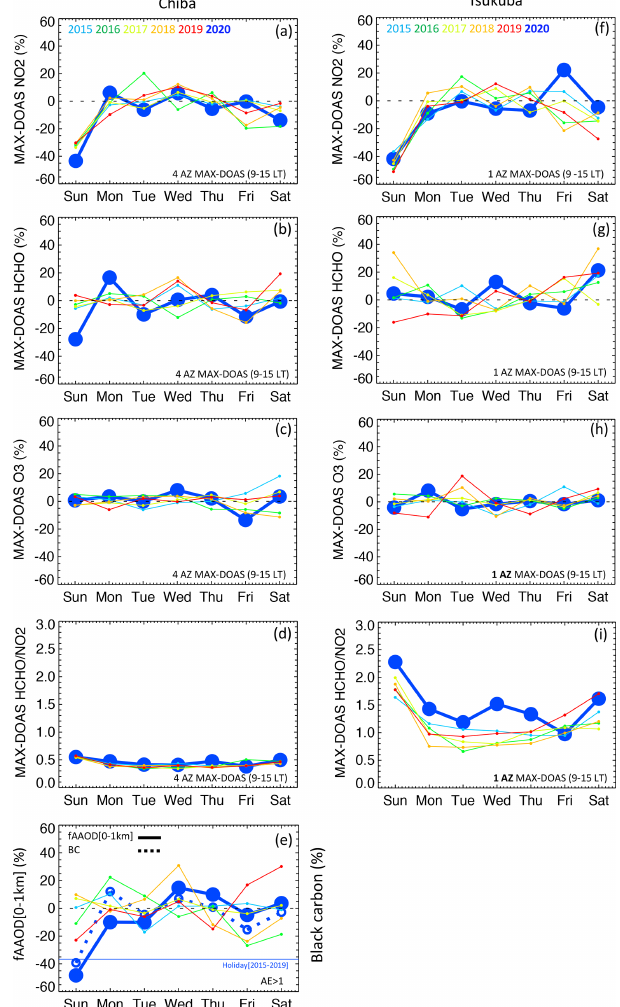
Figure 7. Weekly changes in MAX-DOAS partial tropospheric col- umn (top to bottom) NO 2 , HCHO, O 3 , HCHO / NO 2 , and fAAOD for Chiba (a–e) and Tsukuba (f–i) during 2015–2020. Only data with SZA < 50 were considered in the O 3 dataset; see text for de- tails. Panel (e) includes the weekly cycle of surface BC concentra- tions. BC data were unavailable for